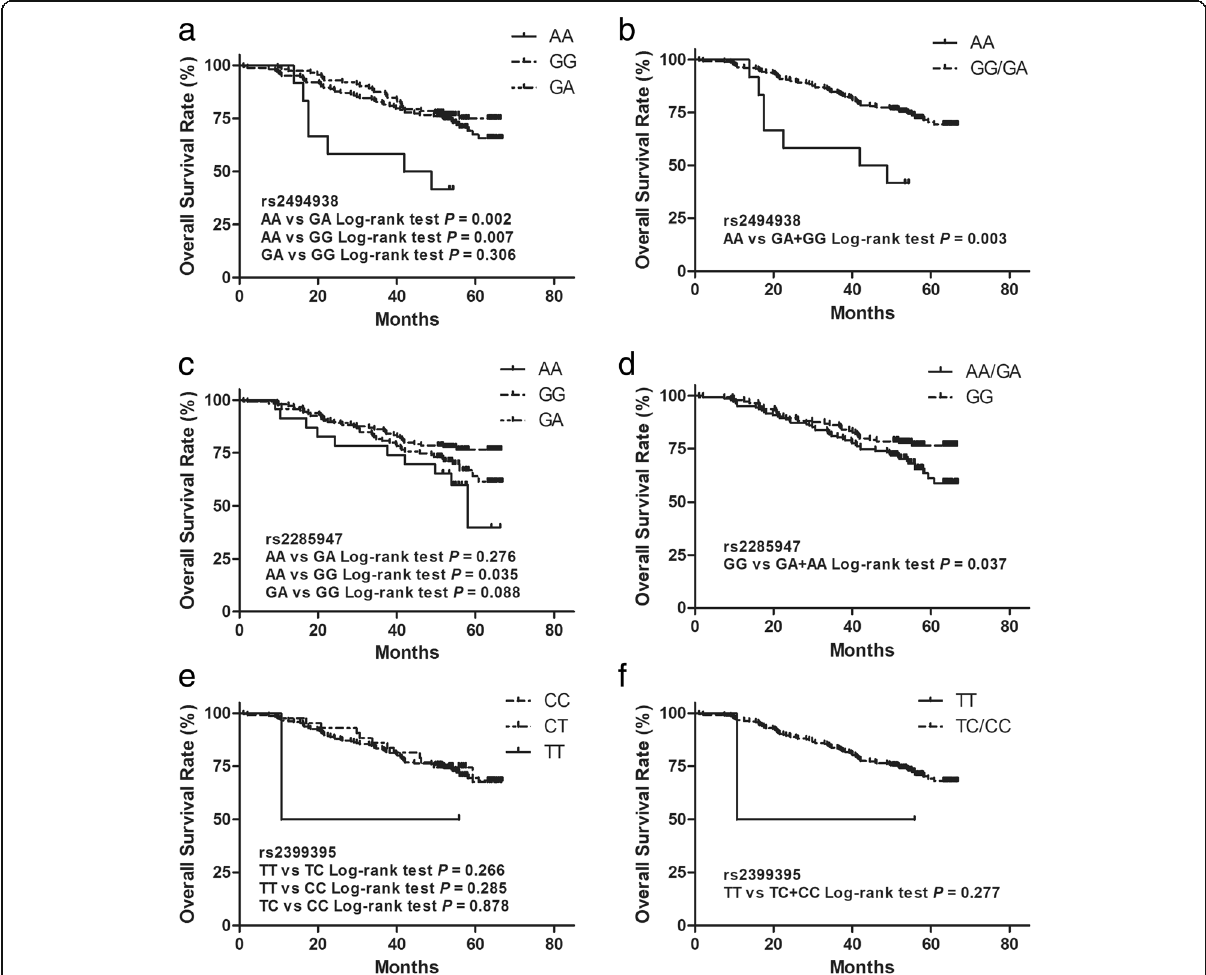
Fig. 1 Kaplan-Meier survival curves for ESCC patients with the different genotypes of rs2494938 (( a , b ) 163 events for GG genotype, 112 events for GA genotype, 12 events for AA genotype), rs2285947 (( c , d ) 145 events for GG genotype, 119 events for GA genotype, 23 events for AA genotype), rs2399395 (( e , f ) 242 events for CC genotype, 43 events for TC genotype, 2 events for TT genotype) polymorphisms; SNP rs2494938 and rs2285947 was correlated with the overall survival in ESCC patients ( a - d ), but not rs2399395 ( e , f